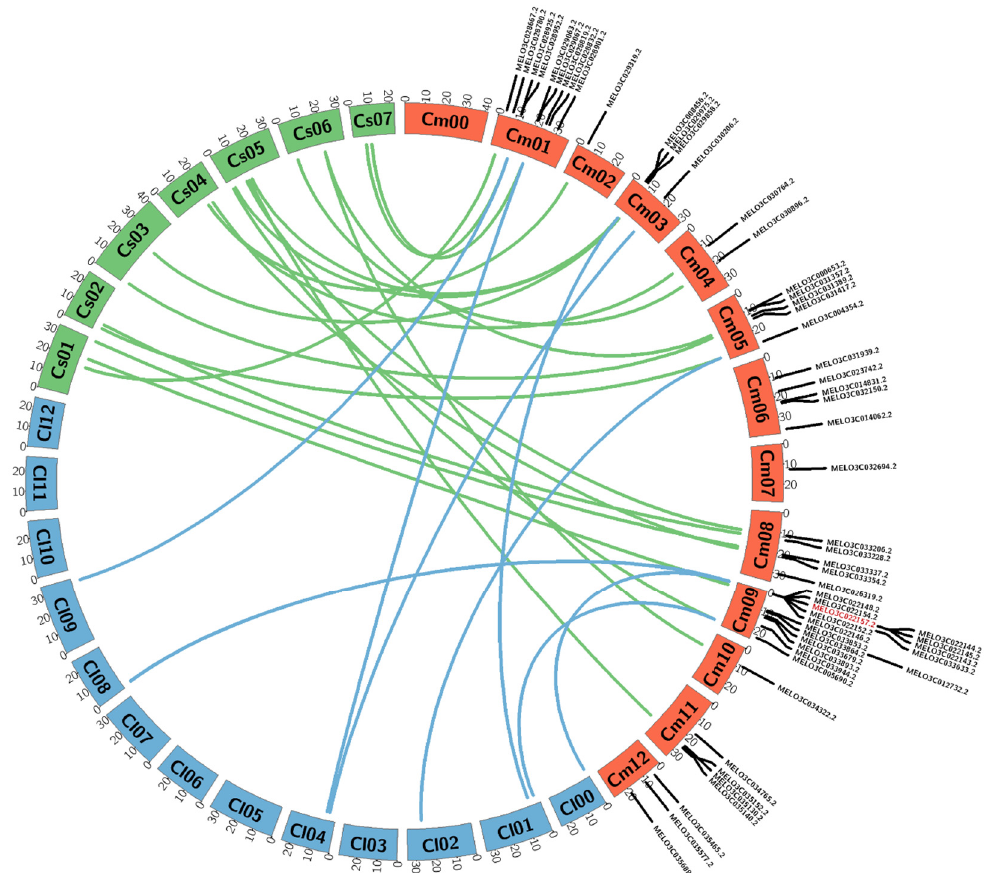
Figure 2. Microsynteny analysis of melon R -genes compared with watermelon and cucumber. Brown orange, blue and green indicate melon, watermelon and cucumber chromosomes, respectively. Red marking indicates genes showing polymorphism between the resistant (PI 353814) and susceptible (PI 614596) parents of the melon. Microsynteny analysis of genes on the melon chromosomes were drawn using the web-based tool Circos (http://circos.ca/software/download/) circos-0.69-9.tgz.